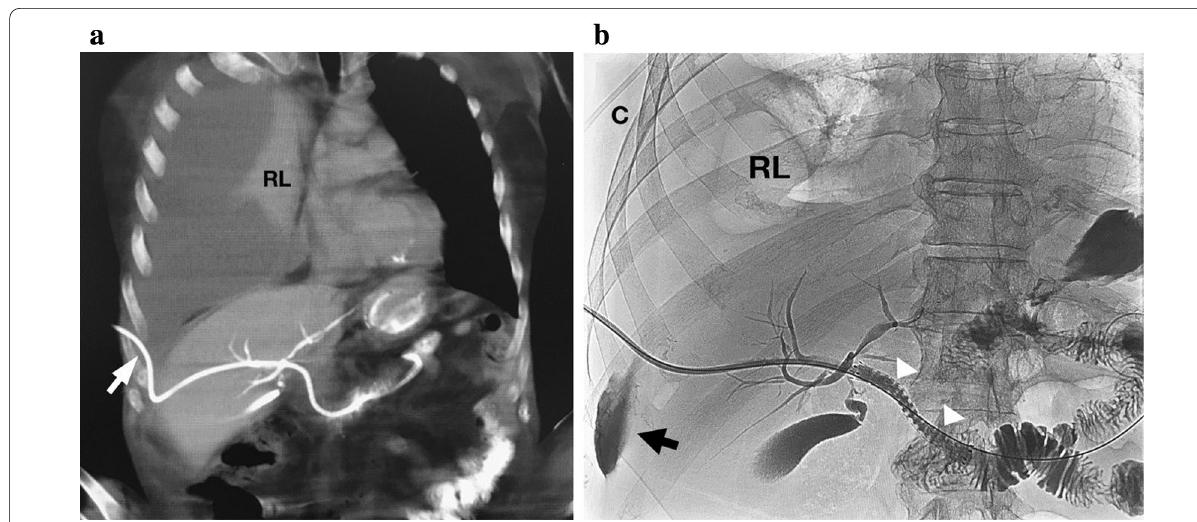
Fig. 2 a Coronal CT MPR reconstruction of the chest and upper abdomen. There is complete obliteration of the right pleural space by the bilous effusion, complete right lung collapse (RL) with left mediastinal shift. The drainage catheter (white arrow) clearly courses through the right costophrenic sulcus. b Image of the right upper quadrant immediately after stent deployment (white arrowheads) and prior to tract embolization. Black arrow points at the opacified right pleural sulcus. The right lung (RL) has partially re-expanded. C: pleural drainage